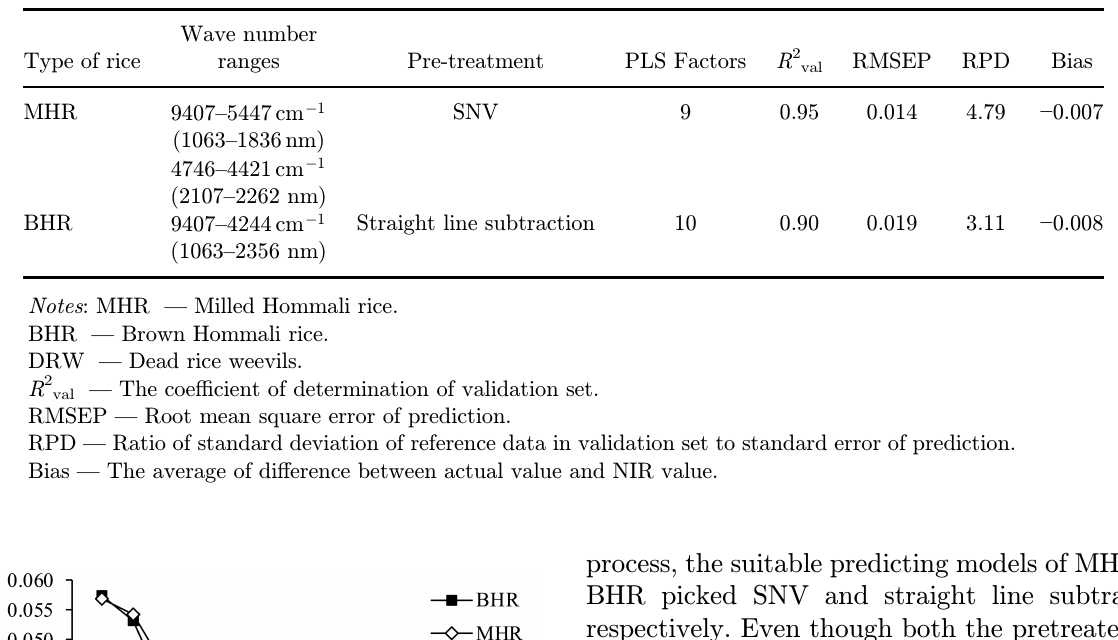
Table 1. Statistics of prediction of DRW (%) in MHR and BHR by partial least square model.